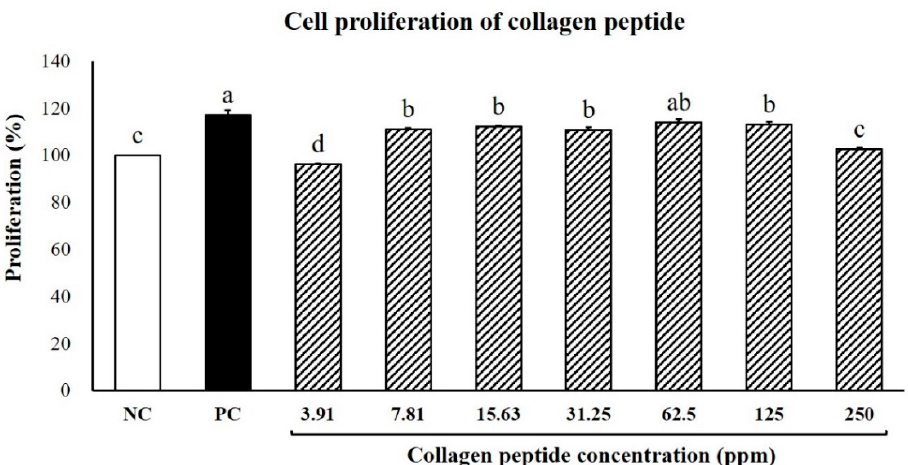
Figure 1. Effects of CP on hDPCs proliferation. NC: negative control (DMEM); PC: positive control (0.2 μ M finasteride); CP: collagen peptides (3.91, 7.81, 31.25, 62.5, 125, and 250 ppm). Values are expressed as the mean ± SE. Values with different superscript letters differ significantly at p < 0.05.